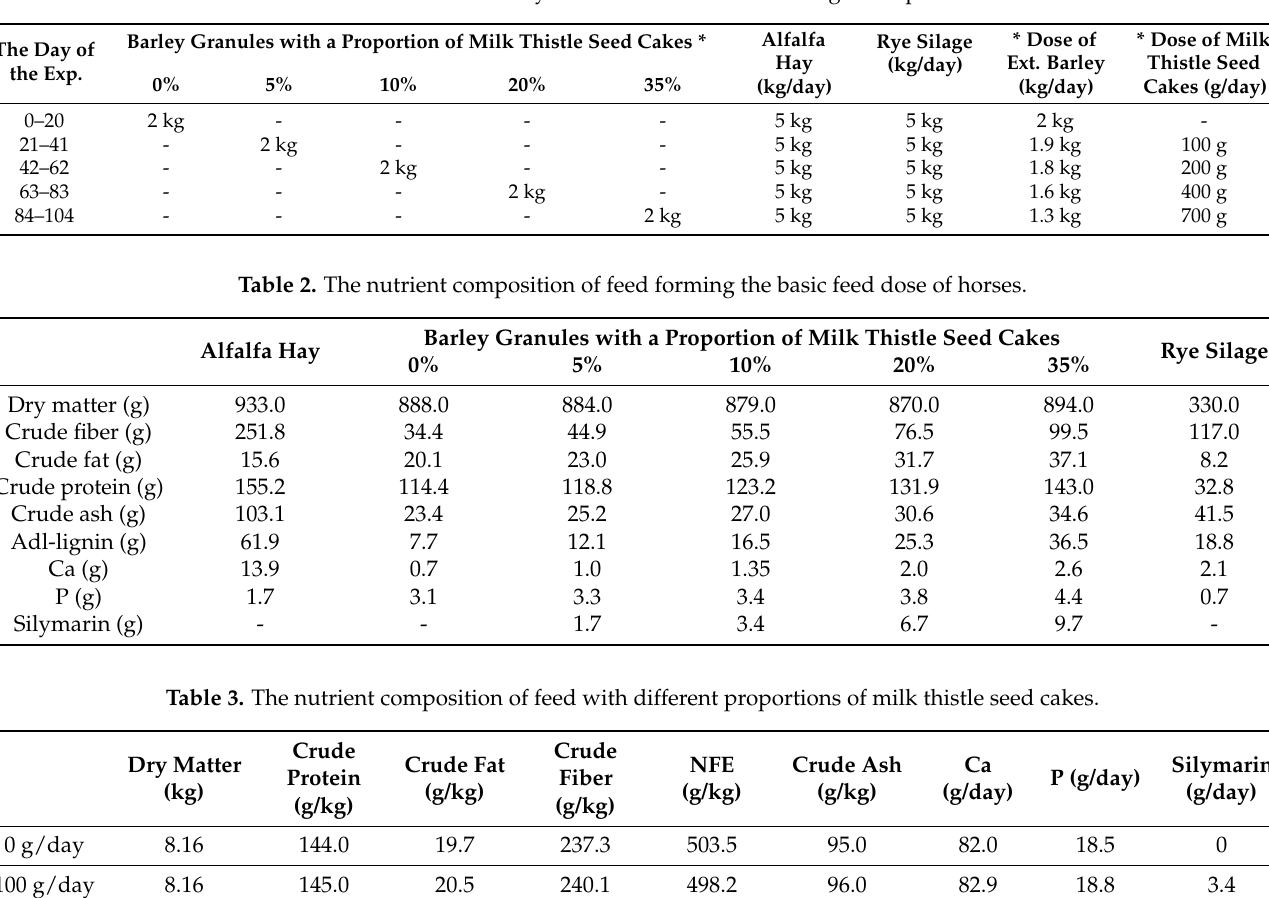
Table 1. The scheme of daily feed doses and intake during the experiment.